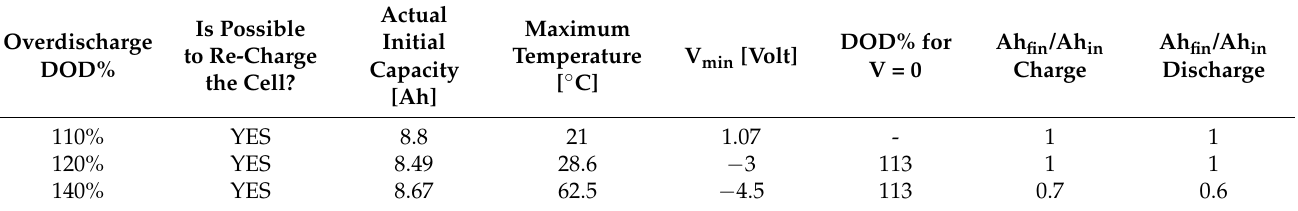
Table 3. Summary of the results obtained from the overdischarge tests on LTO-based anode cells. Table 2. Summary of the results obtained from the overdischarge tests on graphite-based anode cells.